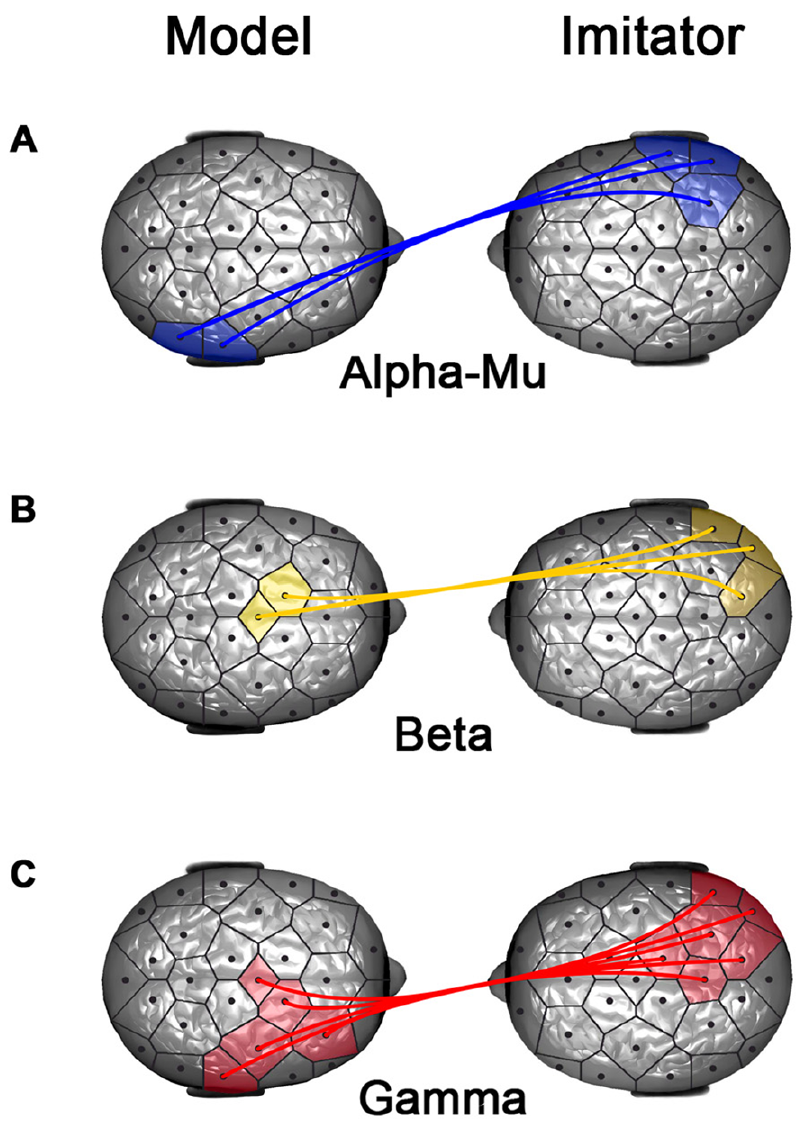
Figure 2. Intersubject neural synchronizations during interactional synchrony. Representation of statistically significant (P , 0.05, nonparametric permutation test, corrected for multiple comparisons) coupling (PLV) for all subjects between electrodes of the model and the imitator: comparison for spontaneous imitation trials between behavioral synchrony episodes and those with no behavioral synchrony (Sync vs. NSync). On the left of the figures the participants are models, on the right the participants are imitators. A. Alpha-Mu band cluster between right centro-parietal regions. B. Beta band cluster between central and right parieto-occipital regions. C. Gamma band cluster between centroparietal and parieto-occipital regions.